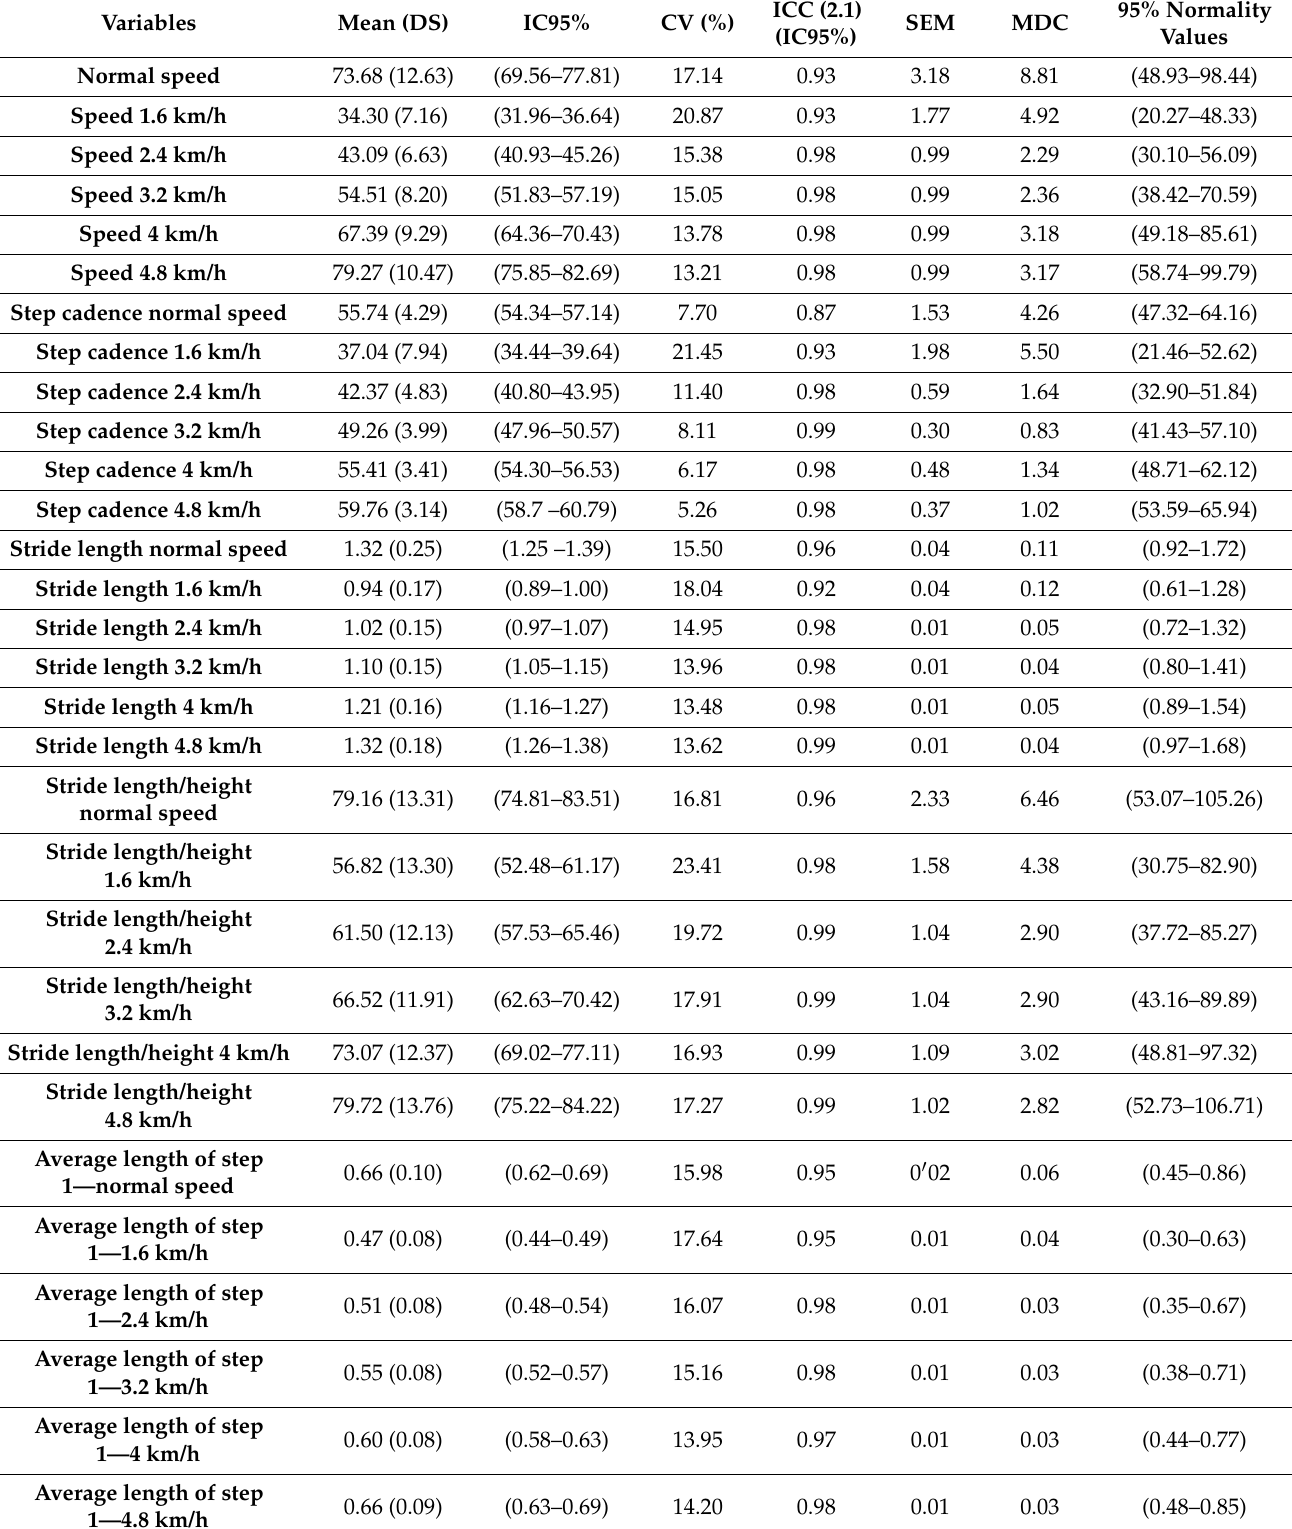
Table 2. Reliability analysis within the variables studied for the first